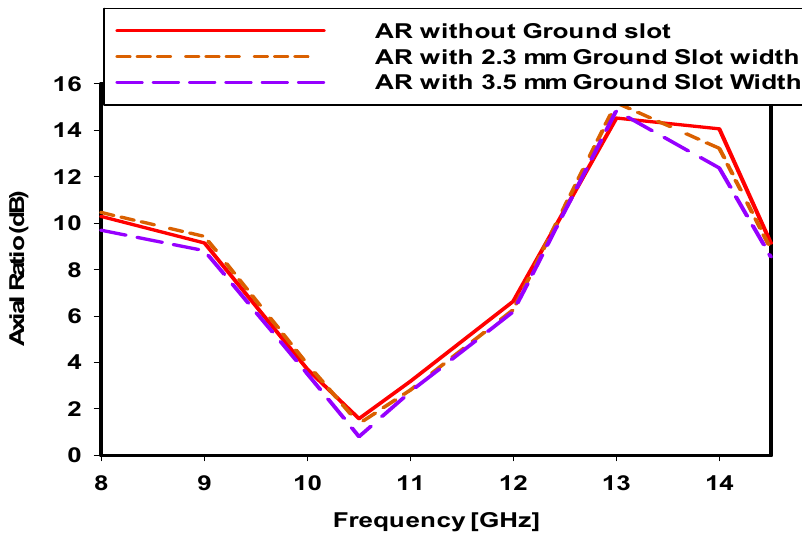
Figure 7. Effect of variation in the ground slot on the Axial Ratio.